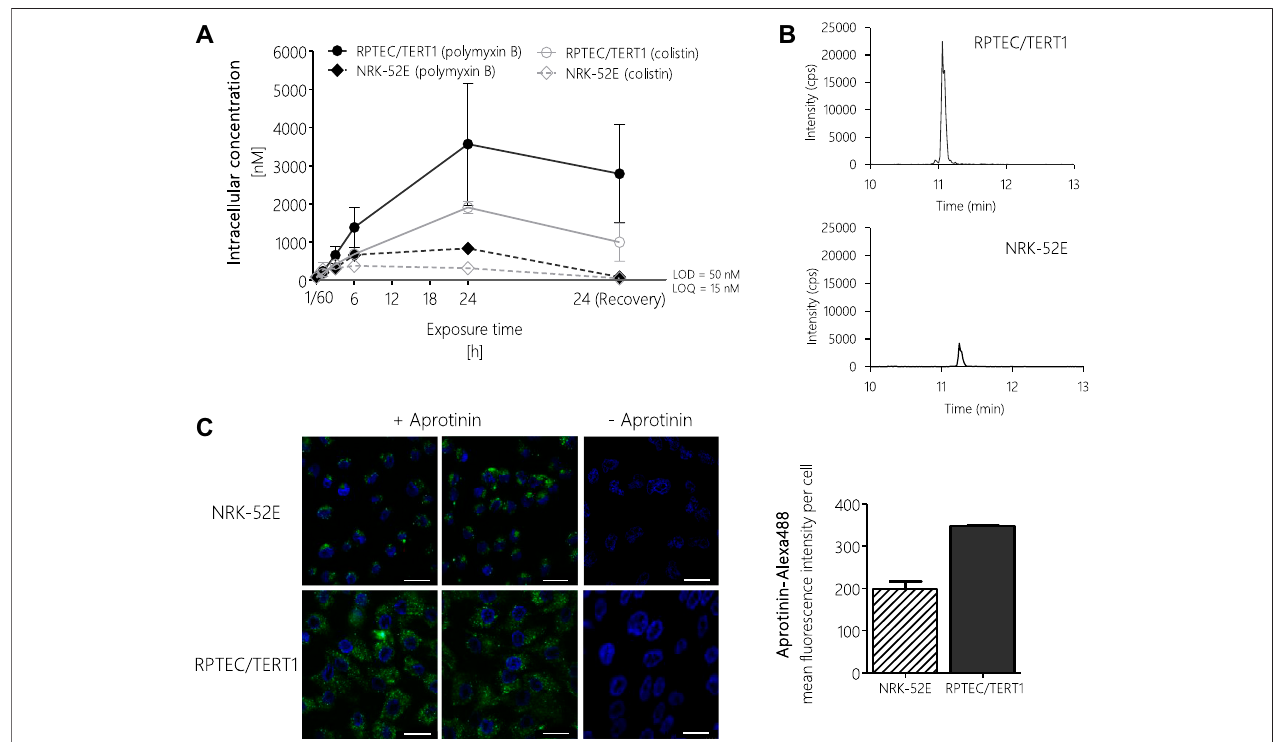
FIGURE6| LC-MS/MS analysisofintracellularconcentrations ofpolymyxin Band colistin inRPTEC/TERT1( ― ) and NRK-52E(---) cells, showing time-dependent accumulation of polymyxins and signi fi cantly higher uptake into RPTEC/TERT1 cells as compared to NRK-52E cells. (A,B) . Confocal fl uorescence images (scale bar: 25 µm) and fl uorescence intensity analysis of Alexa-488 labeled aprotinin uptake (green, left panel) after 4 h incubation ofNRK-52E and RPTEC/TERT1 cells with Alexa- 488labeledaprotinintoassessendocyticactivity (C) ,showingincreasedaccumulationofAlexa-488labeledaprotinininRPTEC/TERT1cellsascomparedtoNRK- 52E cells. Nuclei were stained with DAPI (blue). Images were acquired with a 63 × 1.4 oil UV objective (scale bar: 25 µm). Data are representative of three independent experiments carried out in triplicates. Data are presented as mean ± SD fold change ( n = 3).